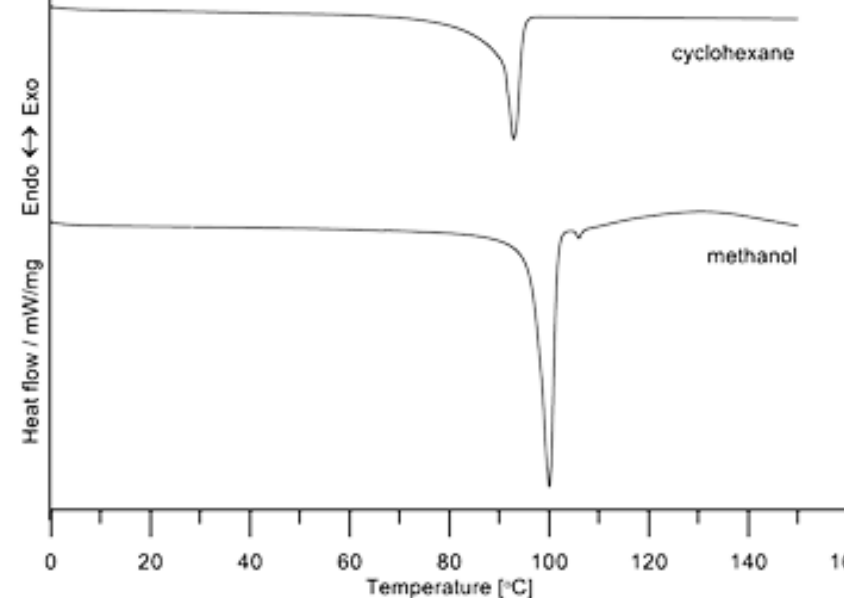
Figure 1. DSC thermograms of MGlc.